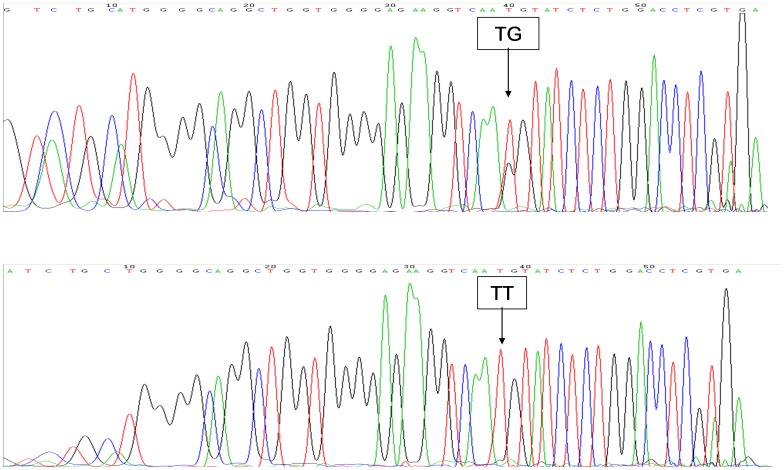
Genotyping results of the gene of CYP2C9*3.
TG represents the TG genotype of CYP2C9*3 gene. TT represents the TG genotype of CYP2C9*3 gene.